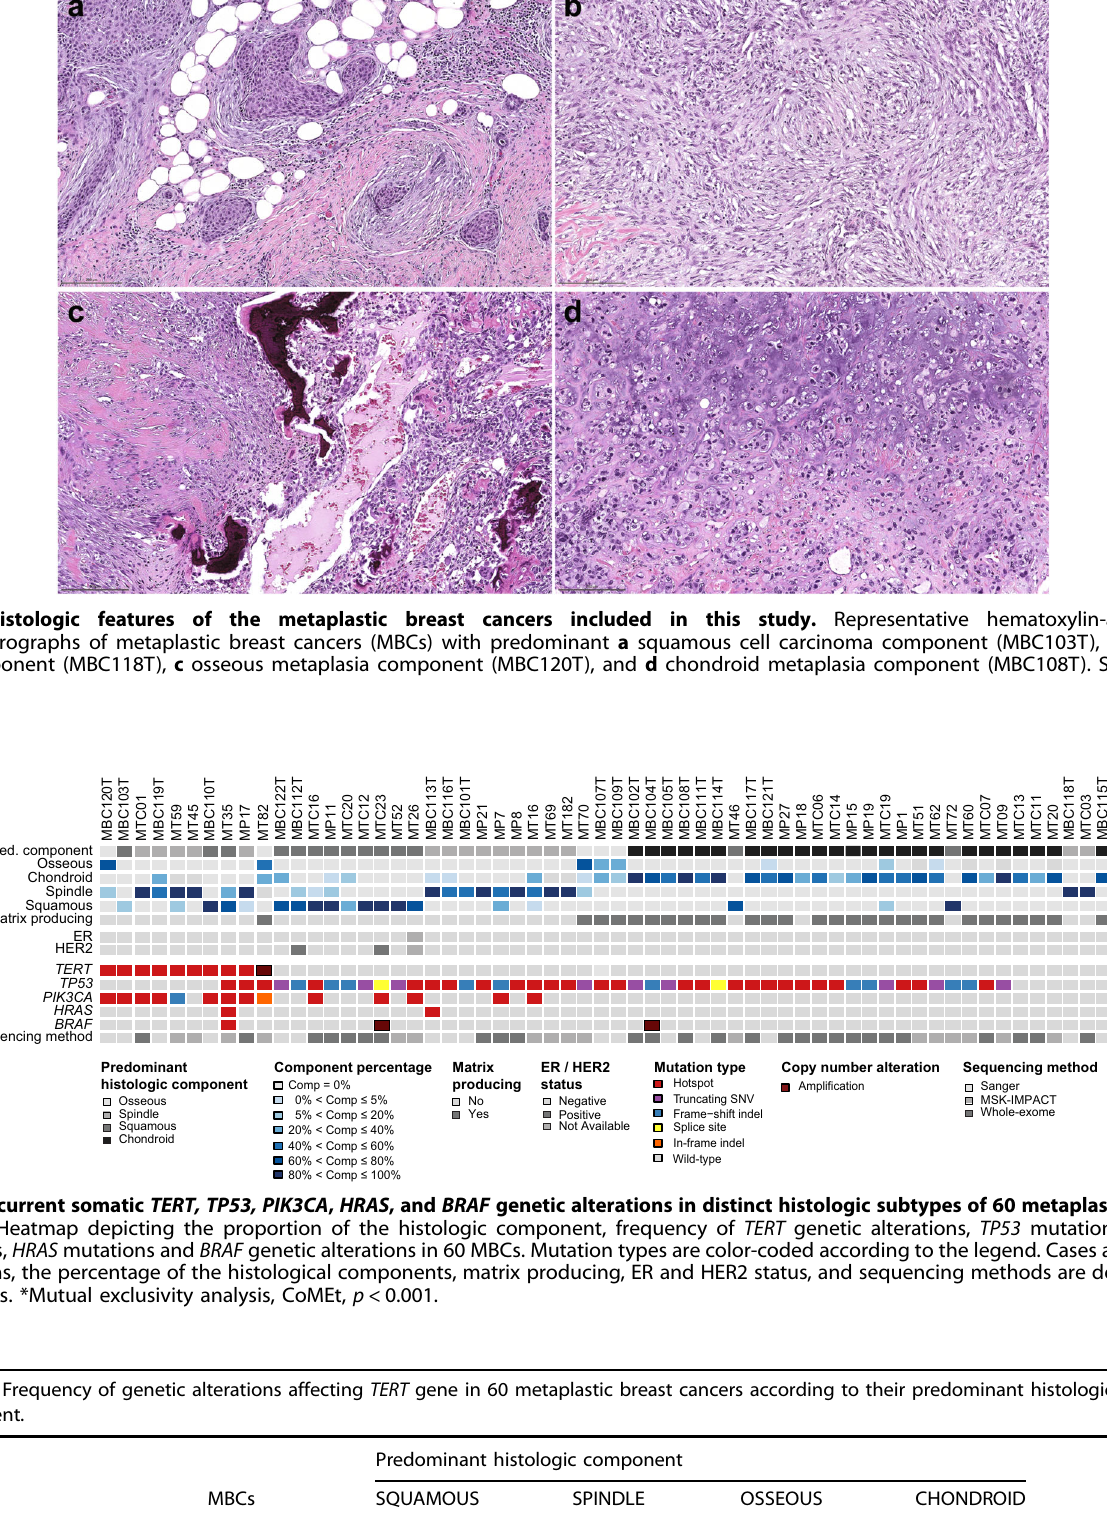
a Statistical signi fi cance was evaluated by Fisher ’ s exact